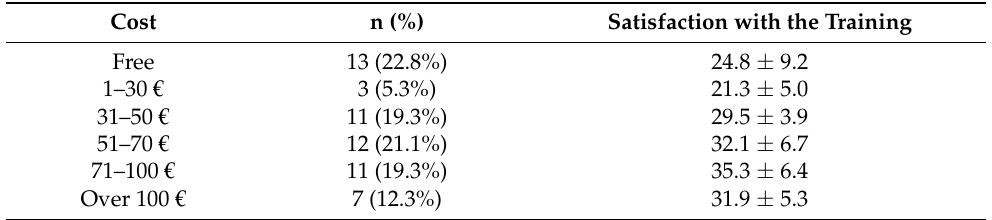
Table 4. Money that users would pay for the course ( p = 0.004).